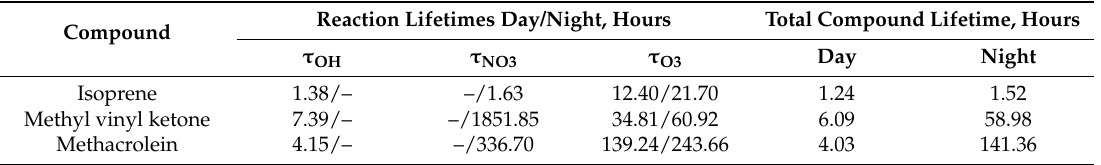
Table 2. Lifetimes during the daytime and night-time for biogenic volatile organic compounds (VOCs) at 298 K.